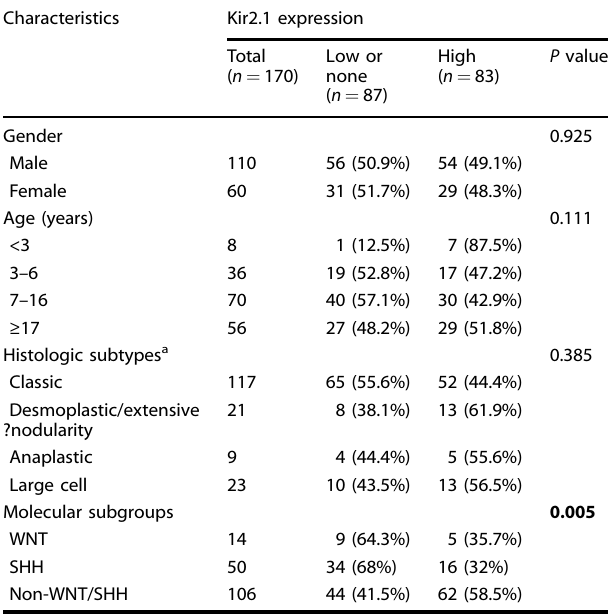
tissues was signi fi cantly higher than in non-tumor tissues (Fig. 1c,